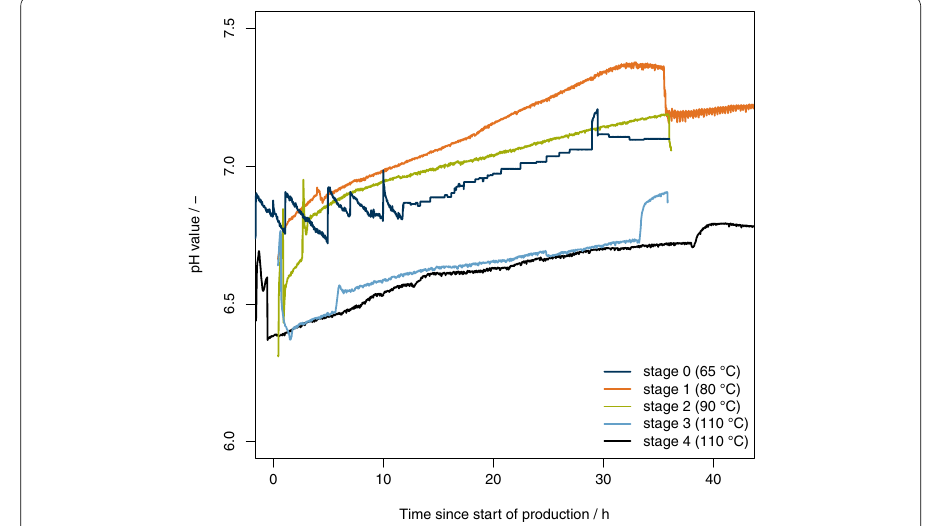
Fig. 8 Development of the pH values during production stages